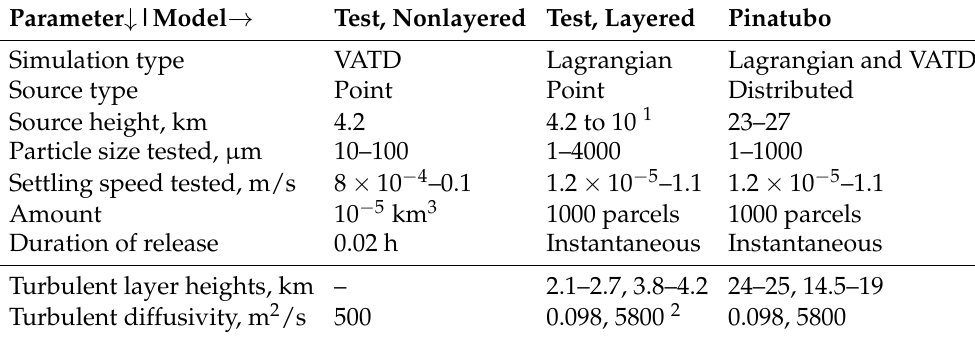
Table 4. Simulation parameters. Duration refers to emission from